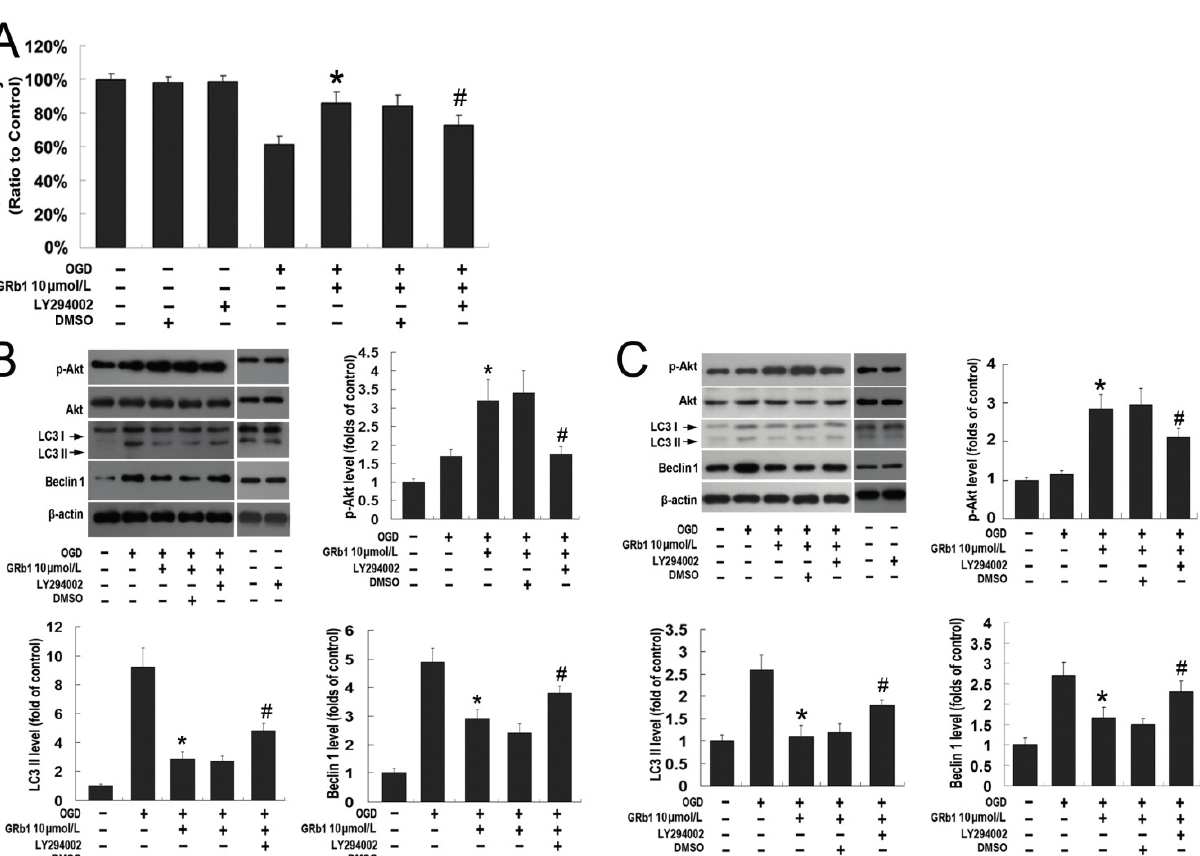
Figure 3. The PI3K/Akt pathway contributed to the protection of ginsenoside Rb1 on lethal autophagy caused by OGD. ( A ) MTT assay of cellular viability in SH-SY5Ycells. Although 10.0 µmol/L GRb1 significantly inhibited OGD-induced cell death in SH-SY5Y cells at 24 h recovery, pretreatment with PI3K inhibitor LY294002 prior to GRb1 reversed the protection of GRb1. DMSO, the solvent of LY294002, did not show any effect on the protection of GRb1; ( B ) Images of western blotting and statistics of optical densities of immunoblots at 12 h recovery; ( C ) Images of western blotting and statistics of optical densities of immunoblots at 24 h recovery. The elevated protein level of phosphor-Akt at Ser473 and the reduced expression of Beclin1 and LC3II caused by GRb1 were all counteracted by pretreatment with PI3K inhibitor LY294002 either at 12 or 24 h recovery. * p < 0.01 versus OGD group; # p < 0.01 versus GRb1 group. Each experiment was performed four